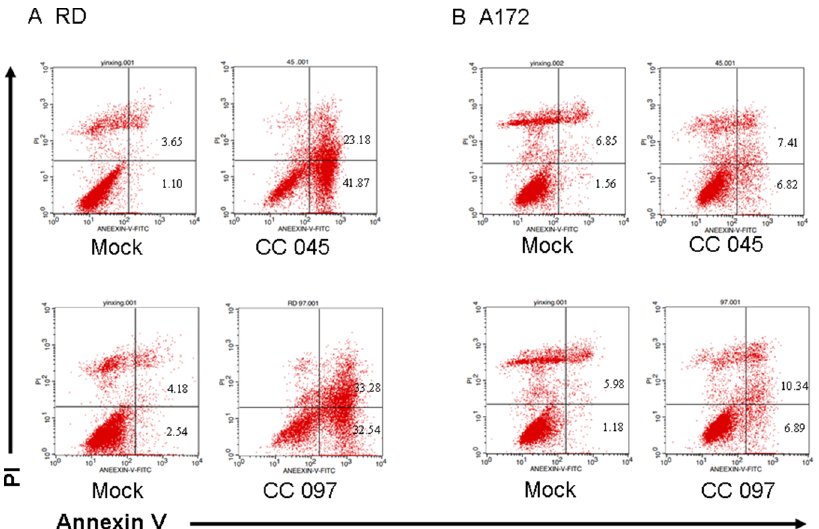
Figure 7. Circulating CA16 strains CC045 and CC097 induce apoptosis. (A) RD cells were inoculated with CC045 and CC097 viruses at the MOI of 1.0 or DMEM as a negative control for 24 h. Cells were washed with PBS and incubated with a FITC-labeled Annexin V and stained with PI, followed by analysis via flow cytometry. Annexin V-positive/PI-negative cells were considered to be in early phase apoptosis. Annexin V-positive/PI- positive cells were considered to be in late phase apoptosis. (B) A172 cells were inoculated with CC045 or CC097 at the MOI of 1.0 for 24 h or DMEM as a negative control for Annexin-PI staining. Representative images are shown of three individual experiments (n=3) performed for each cell line. * P , 0.05.